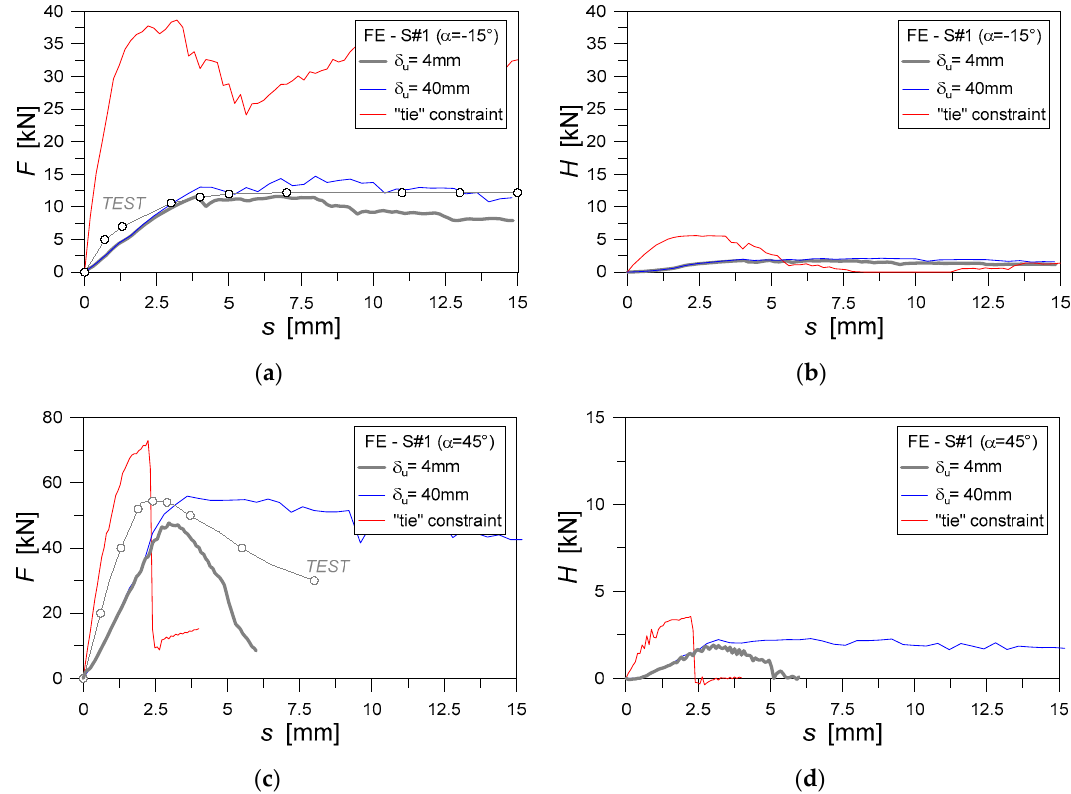
Figure 16. Analysis of mechanical interaction and CZM effects on the PO numerical response of TTC